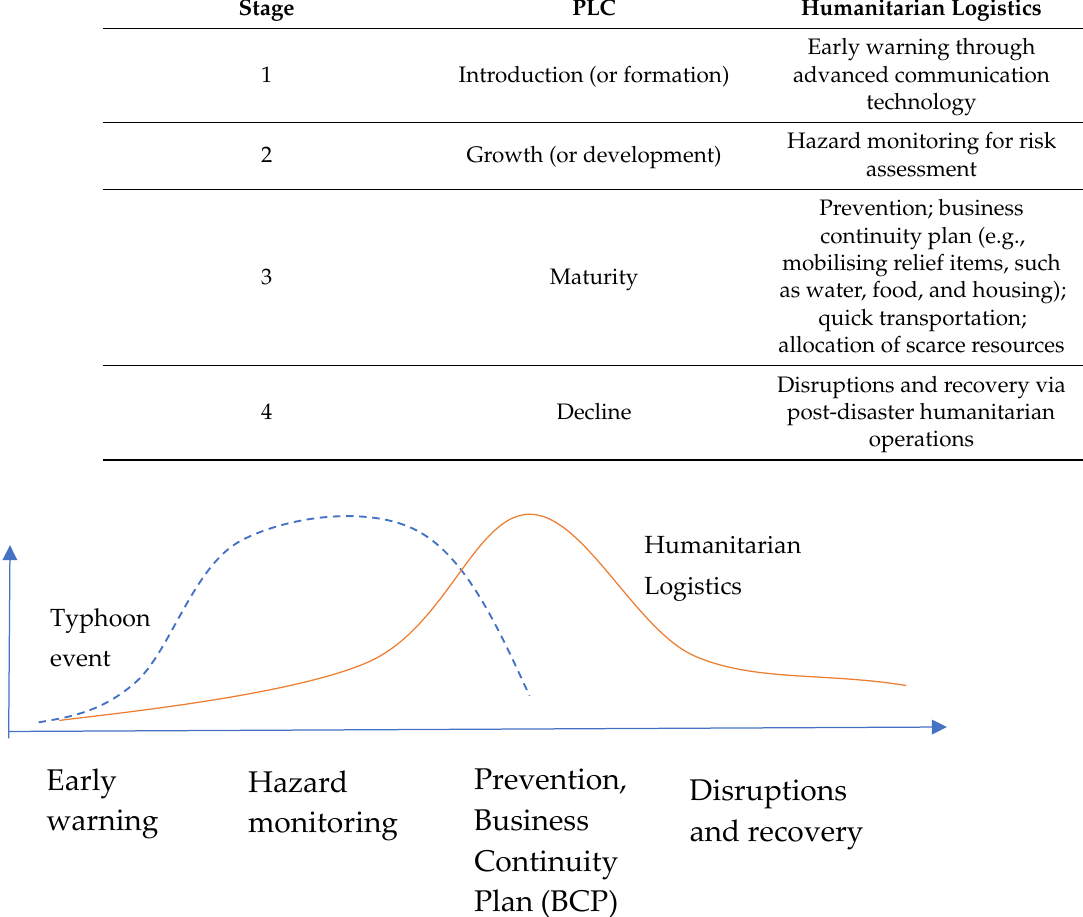
Figure 2. The interface of a typhoon event and humanitarian logistics.